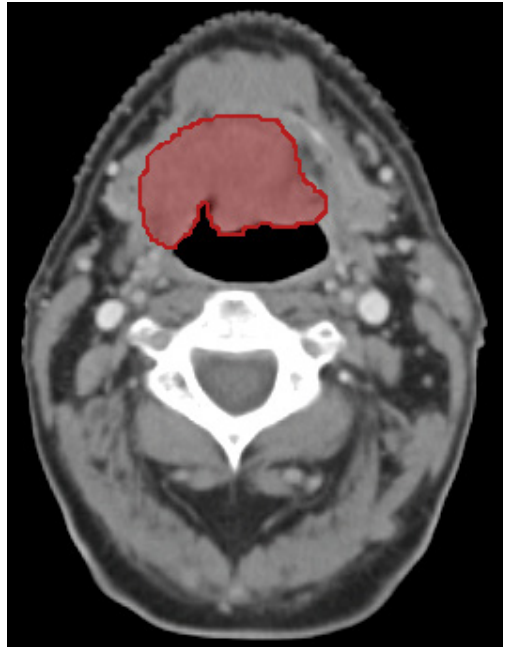
Figure 1. Computed tomography image of patient with stage IVA oropharyngeal cancer in transverse plane. The primary tumour is shown outlined in red.